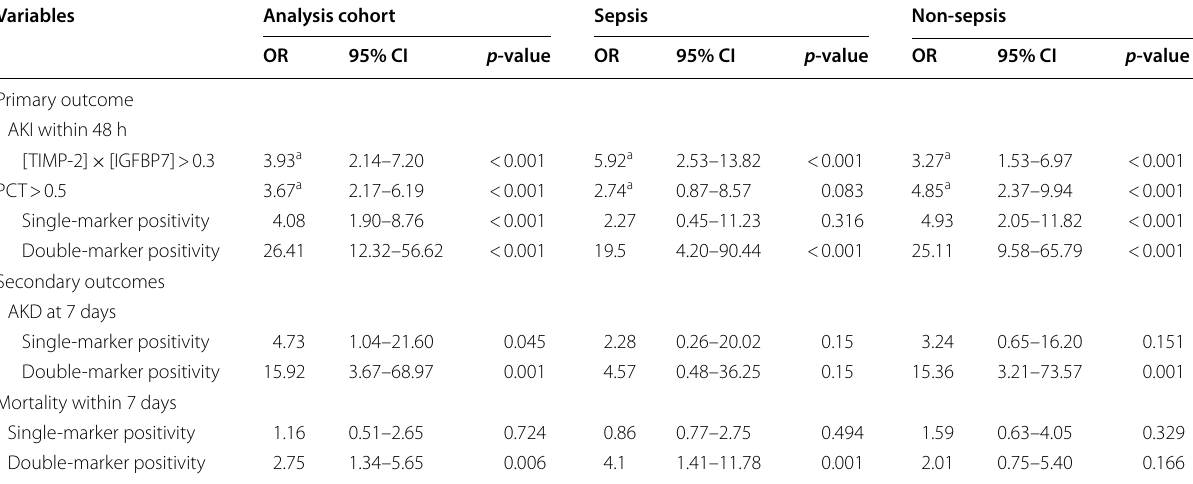
Table 3 Risk assessment for primary and secondary outcomes in the entire population and in septic and non-septic